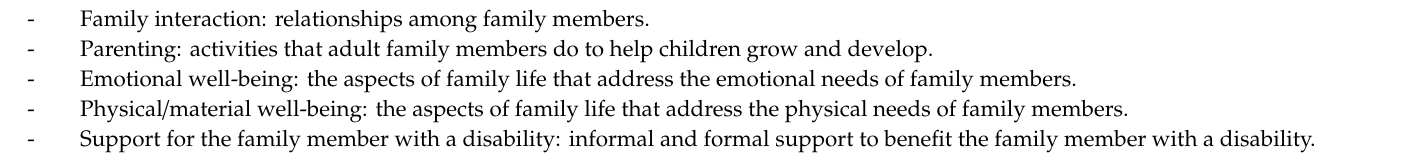
Beach Center FQoL